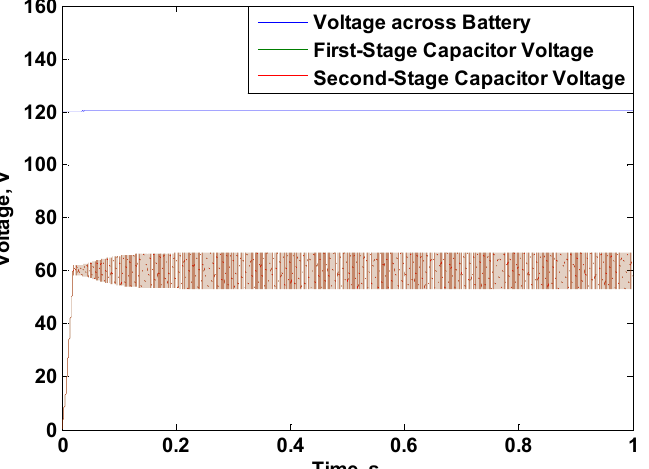
Figure 23. Output, first-stage capacitor and second-stage capacitor voltages at a reference current